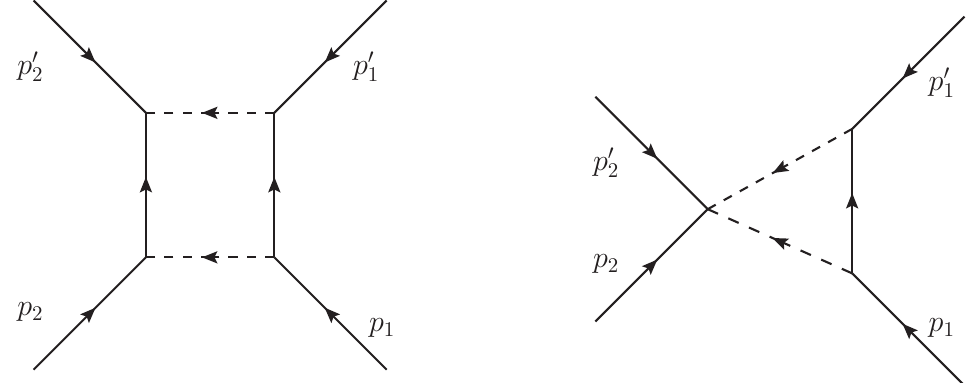
Figure 1. Different topologies for the calculation of the leading singularities. Thick lines represent all possible external particles considered in the text, whereas dashed lines represent intermediate